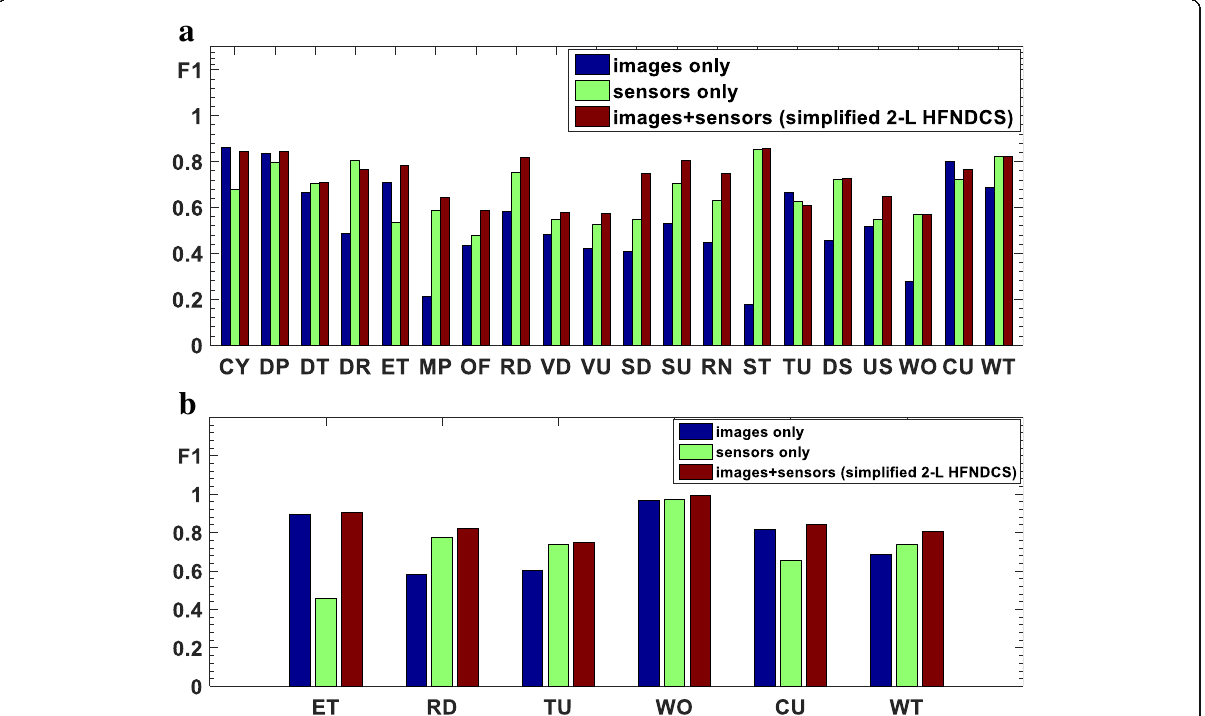
Fig. 13 F 1 measures of the fusion results for M -20 ( a ) and M S -6 ( b ) by simplified